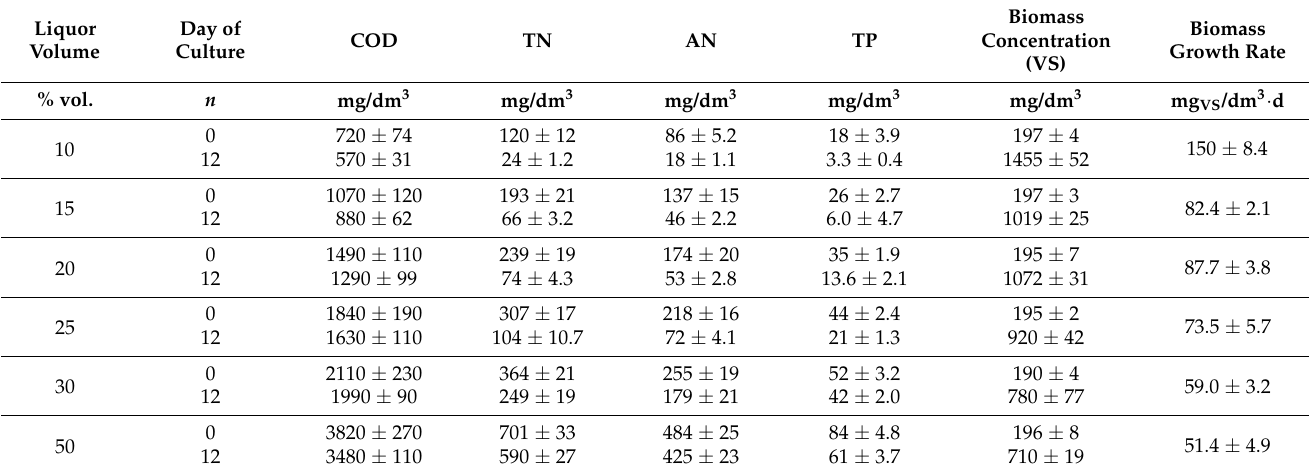
Table 3. Chlorella vulgaris biomass growth rates and trends in pollutant